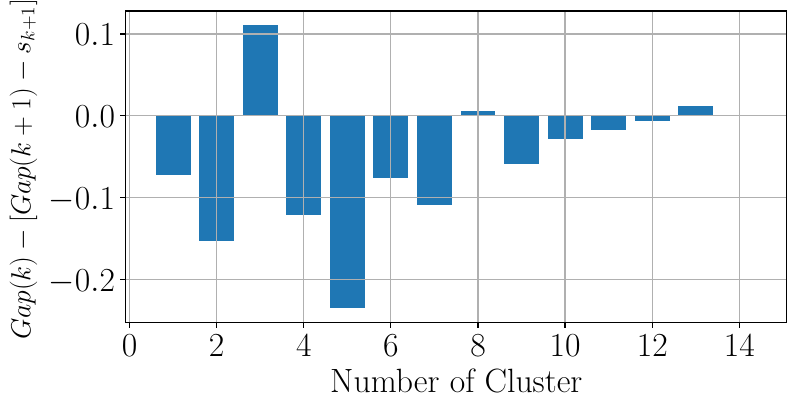
Figure 6. Evaluation of the optimal number of clusters using the GAP statistic